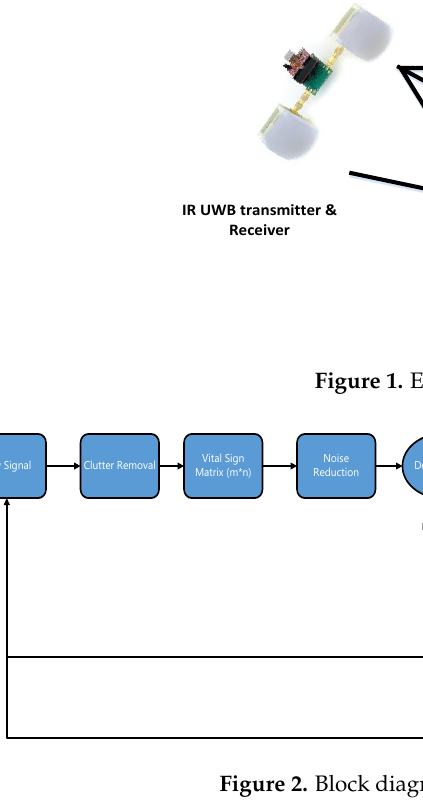
Figure 2. Block diagram of vital sign monitoring.